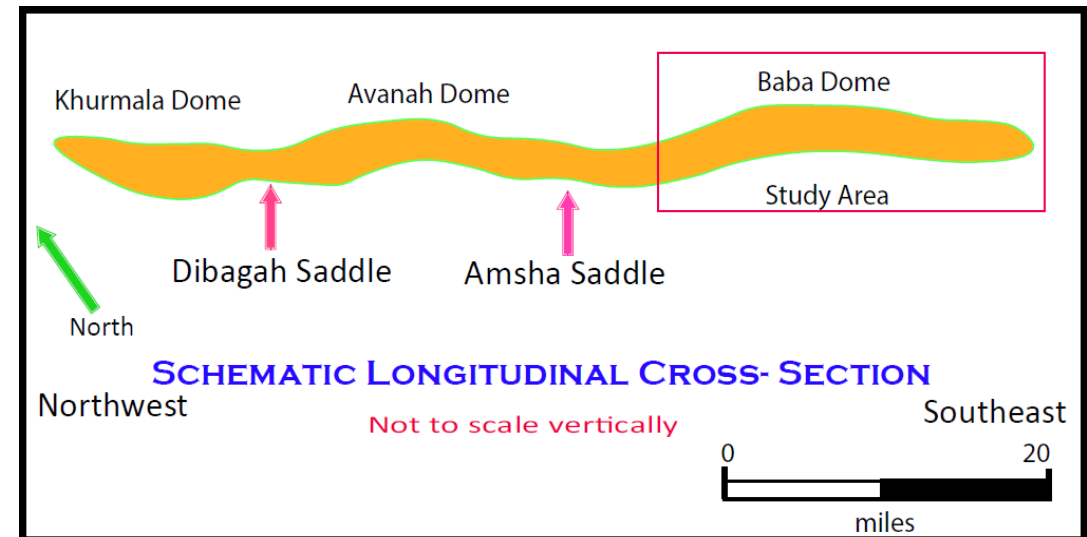
Figure 1. Illustration of the general location of oilfields in NE-Iraq. Close up the Baba Dome inside the lower circle shape.